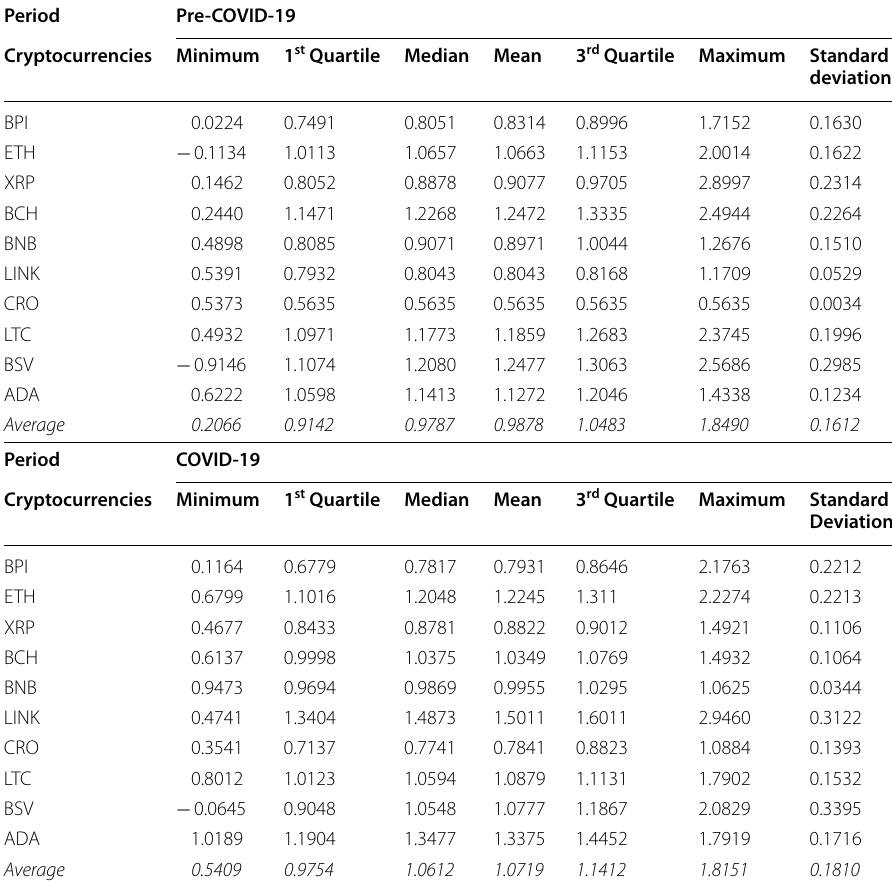
estimates of the cryptocurrencies β imt (cid:31) (cid:29) (cid:30)